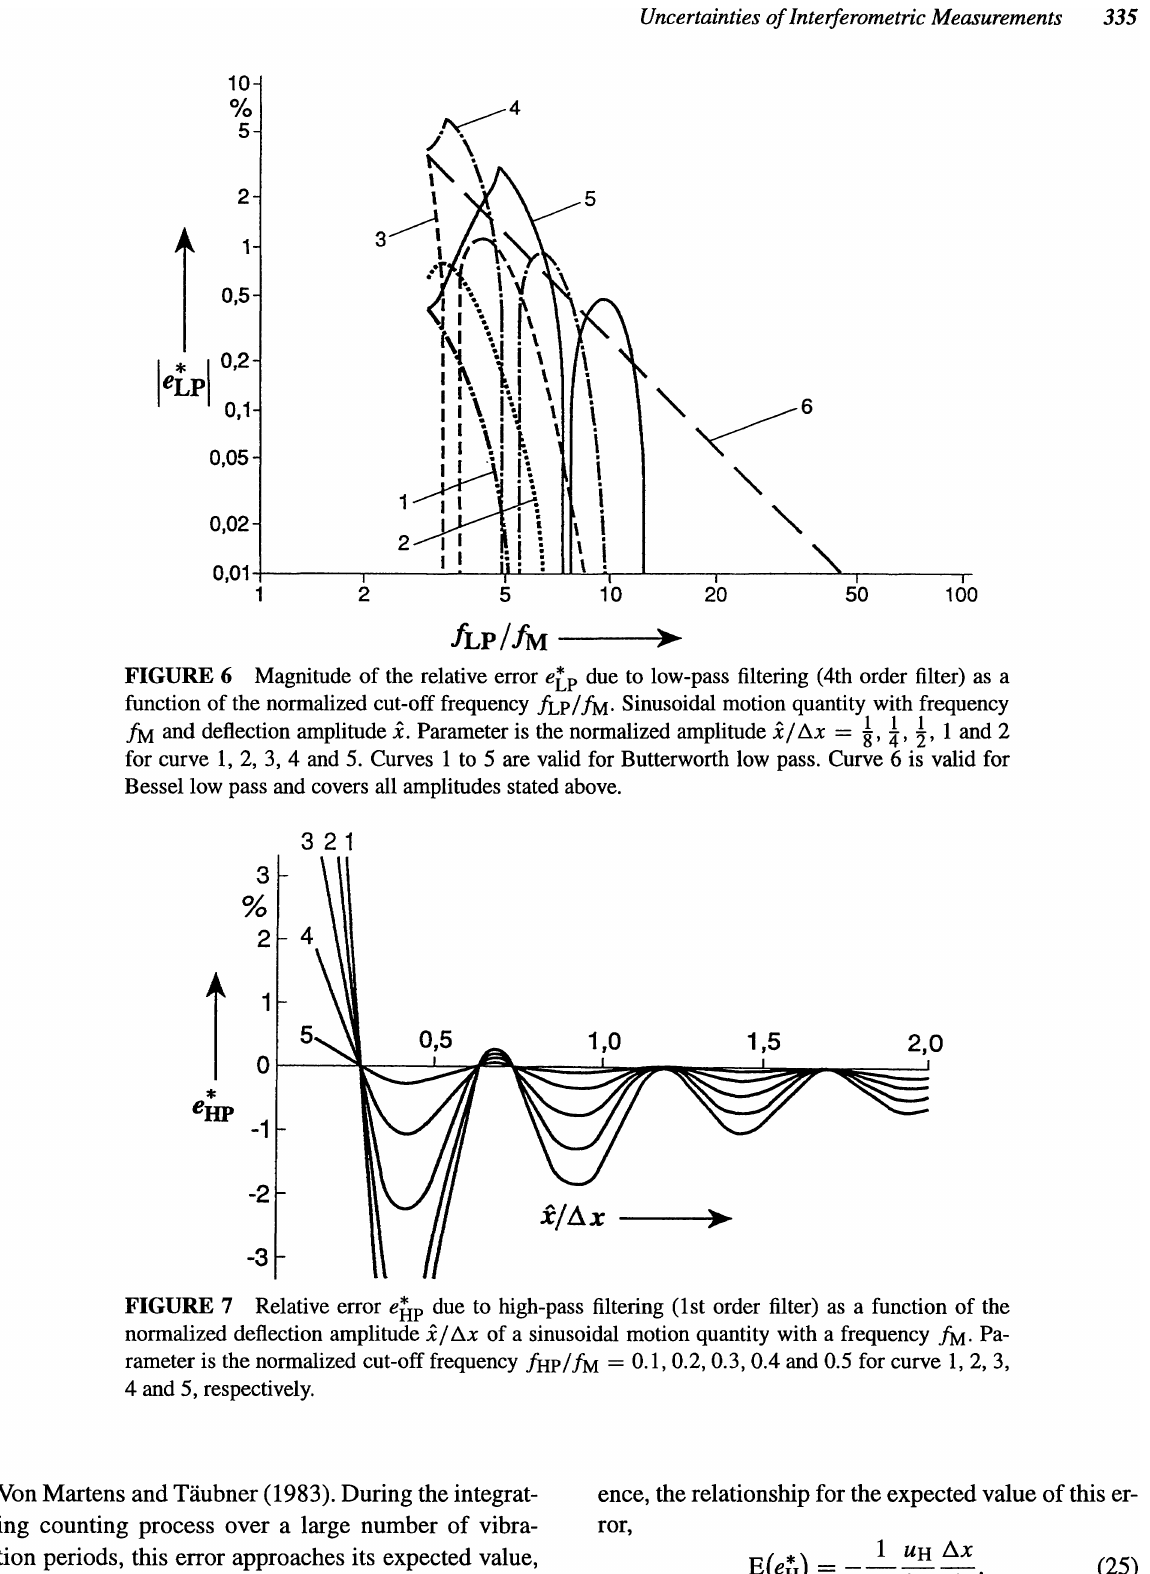
FIGURE 7 Relative error e HP due to high-pass filtering (1st order filter) as a function of the normalized deflection amplitude i I D.x of a sinusoidal motion quantity with a frequency fM. Pa rameter is the normalized cut-off frequency fHpl fM = 0.1,0.2,0.3,0.4 and 0.5 for curve 1,2,3, 4 and 5,